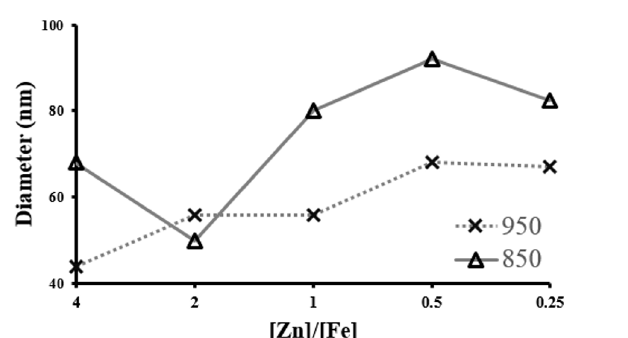
Fig. 5 . Diagram of Average diameters of resulted carbon nanotubes using catalysts with the [Zn]/[Fe] proportion of 4, 2, 1, 0.5 and 0.25 at reaction temperatures of 850 and 950 °C.